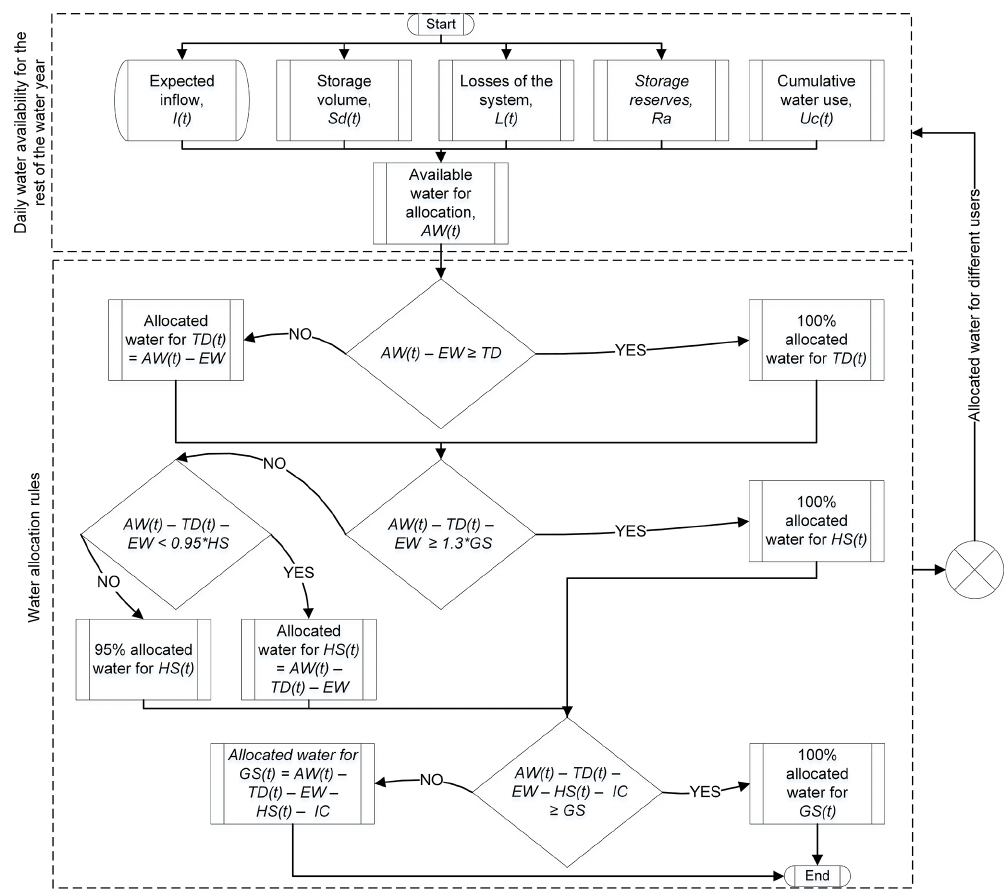
Figure 3. Water allocation framework used to simulate the daily water availability for the rest of the water year and emulate the allocated water for different users based on allocation rules in the Murrumbidgee basin. The input variable is the expected inflow into the reservoirs.